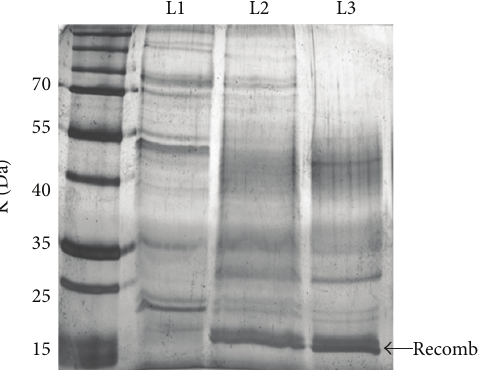
Figure 2: Production of native FGH (nFGH) and optimized FGH (oFGH) in P. pastoris . The expression vectors that contain oFGH and nFGH were transformed separately into Pichia pastoris strain X-33 using EasySelect Pichia Expression kit. A pilot experiment was carried out to identify the ability of P. pastoris to produce recombinant FGH as an extracellular protein. The SDS-PAGE result showed that the recombinant nFGH and oFGH were produced by P. pastoris at expected size of 22 kDa. L1 = control; L2 = nFGH; L3 =